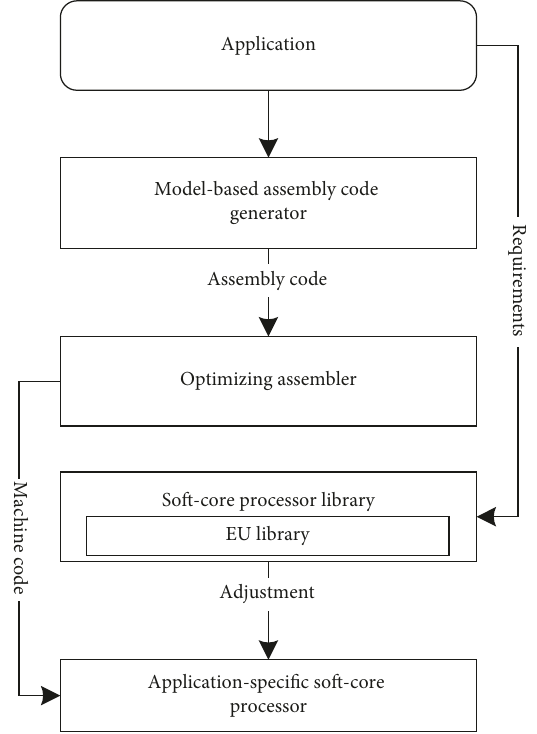
Figure 4: ViSARD tool-chain (simplified, based on